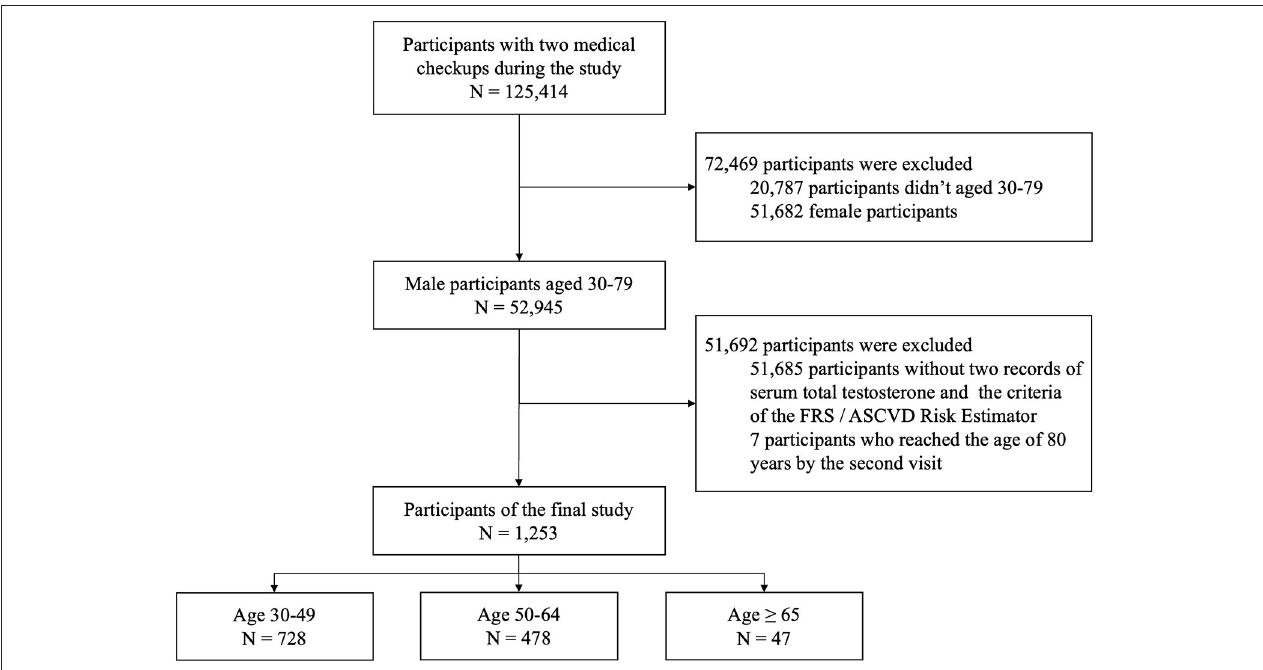
FIGURE 1 | The flow chart illustrates the number of included and excluded participants, the reasons for exclusion, and the final number of participants. FRS, Framingham Risk Score (2008); ASCVD Risk Estimator, Atherosclerotic cardiovascular disease Risk Estimator (2013).